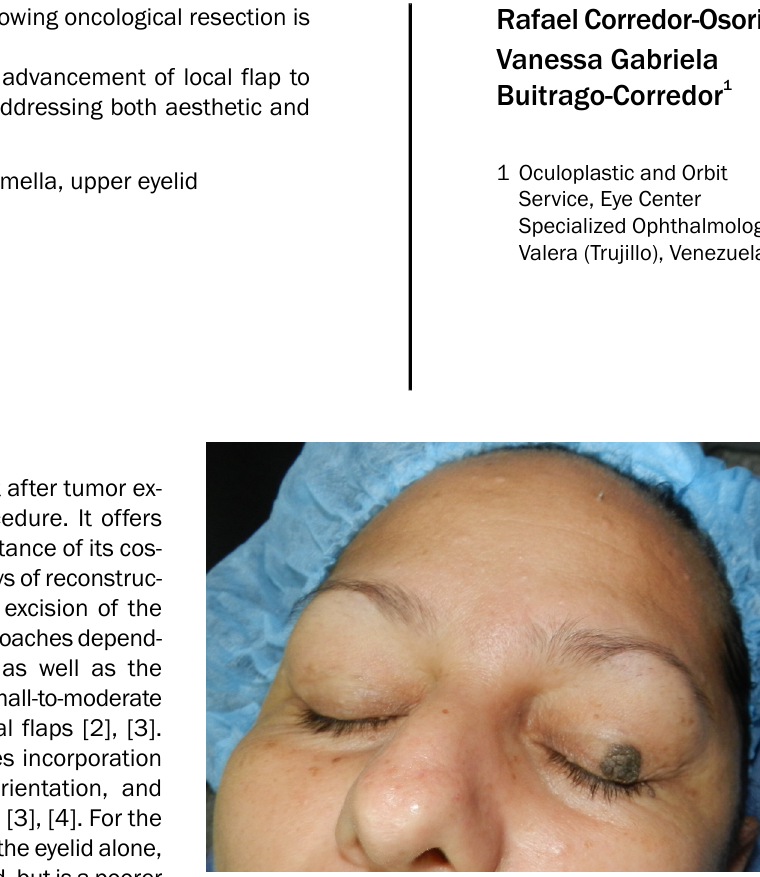
Figure 1: A round shaped 1.0 cm diameter circumscribed elevated and had brown pigmented color lesion on the left upper